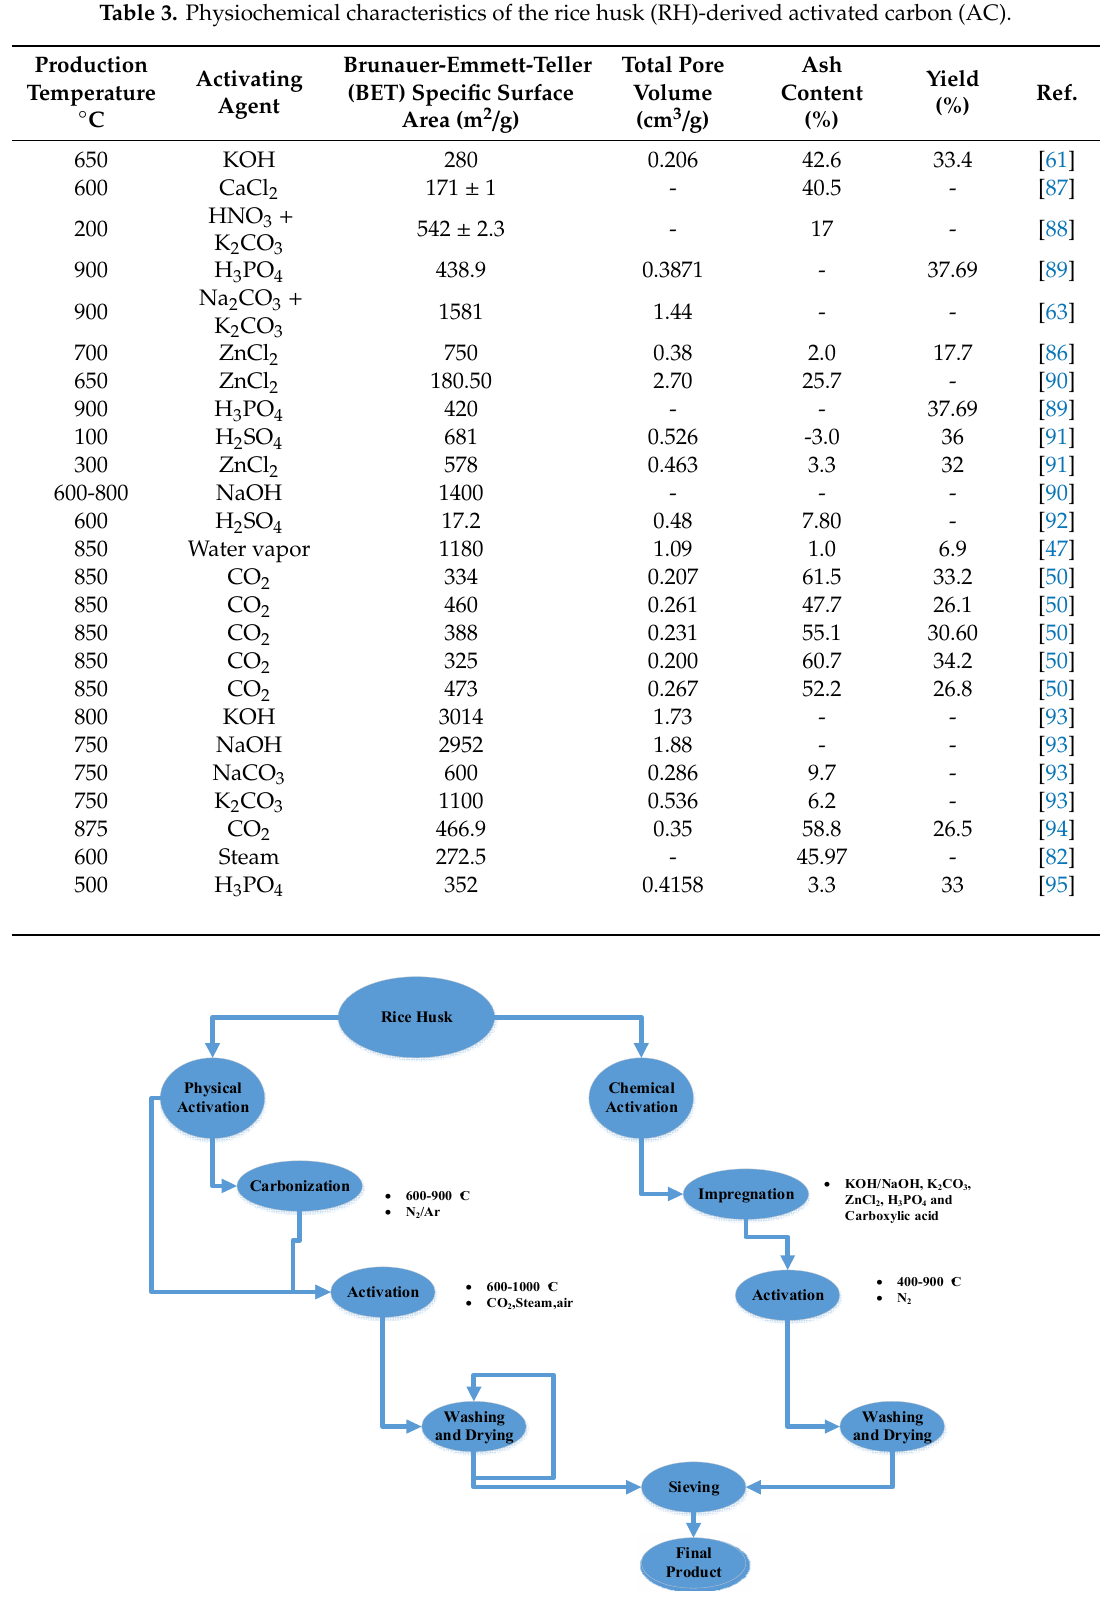
Figure 2. Outline of AC preparation from RH. In figure, KOH, ZnCl 2 , H 3 PO 4 , and N indicate potassium hydroxide, zinc chloride, phosphoric acid and nitrogen, respectively. Reproduced with permission from [38]; Copyright © 2012, American Chemical Society.